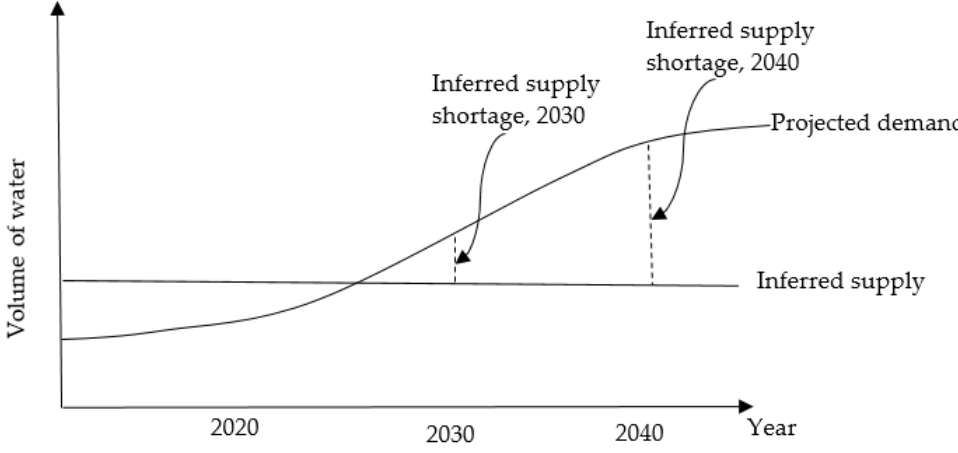
Figure 2. Schematic Illustration of Inferred Water Supply Shortage Calculations.